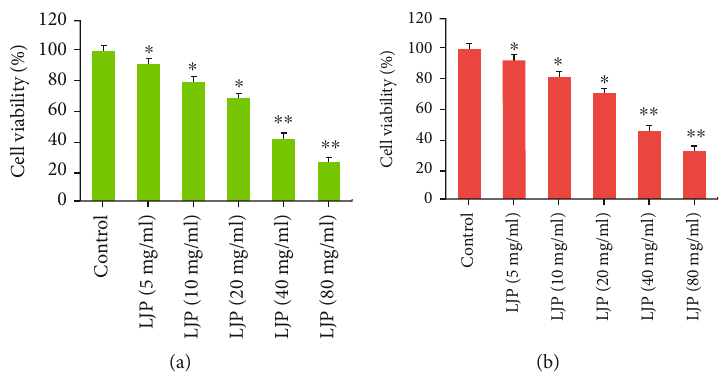
Figure 3: Proliferation of A549 and NCI-H292 cells. ∗ P < 0 : 05 versus control group. CCK8 assay was used to detect cell viability of A549 (a) and NCI-H292 (b) after treated with di ff erent concentrations of LJP for